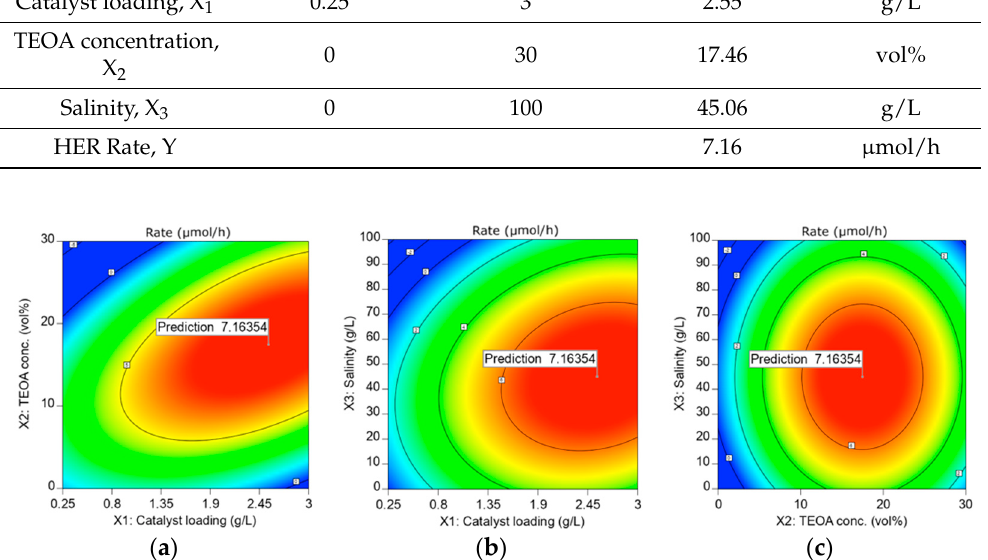
Table 5. The optimum conditions for HER via numerical optimization.